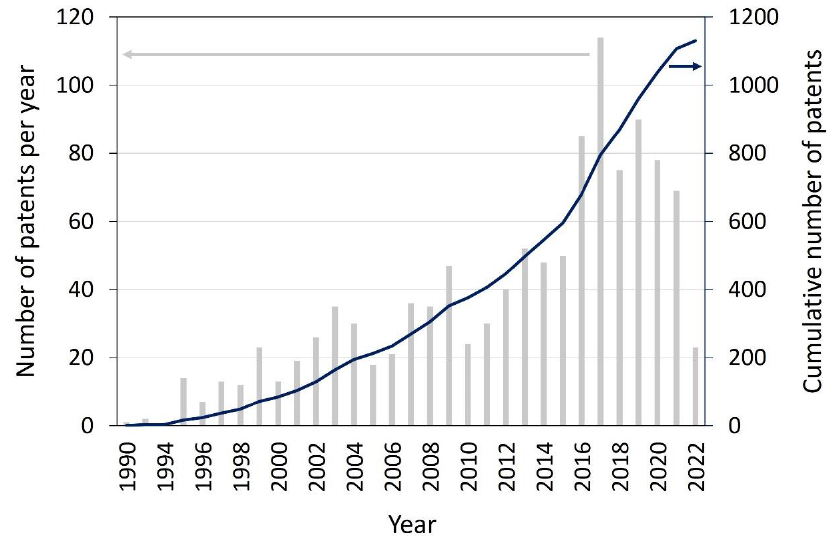
Figure 1. Patents found with Espacenet, EPO ’ s free patent database (worldwise.espace.com), when we were using the search terms “ self-cleaning coating ” OR “ self-cleaning surface ” ) AND “photocatalytic” on 10 October 2022.